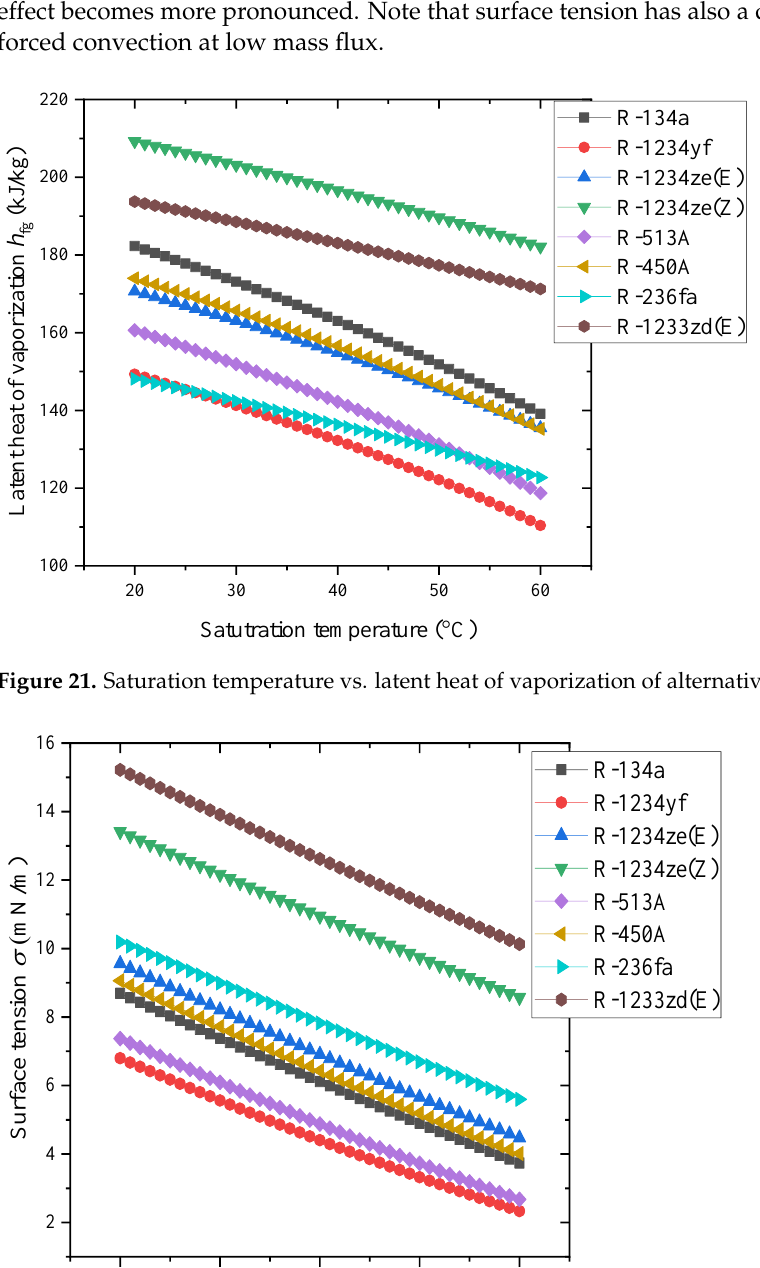
Figure 20. Saturation temperature vs. liquid pressures of alternative refrigerants to R-134a [1].